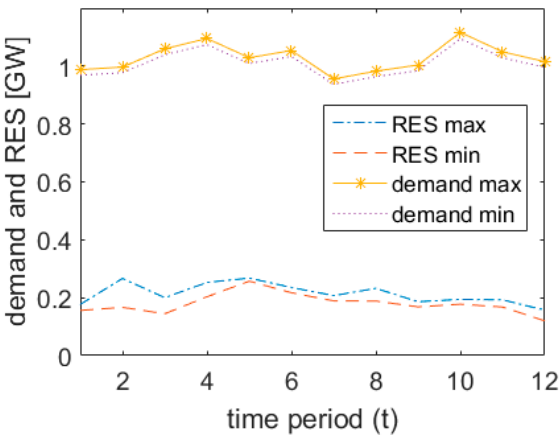
Figure 3. Demand and renewable energy sources (RES) forecast.